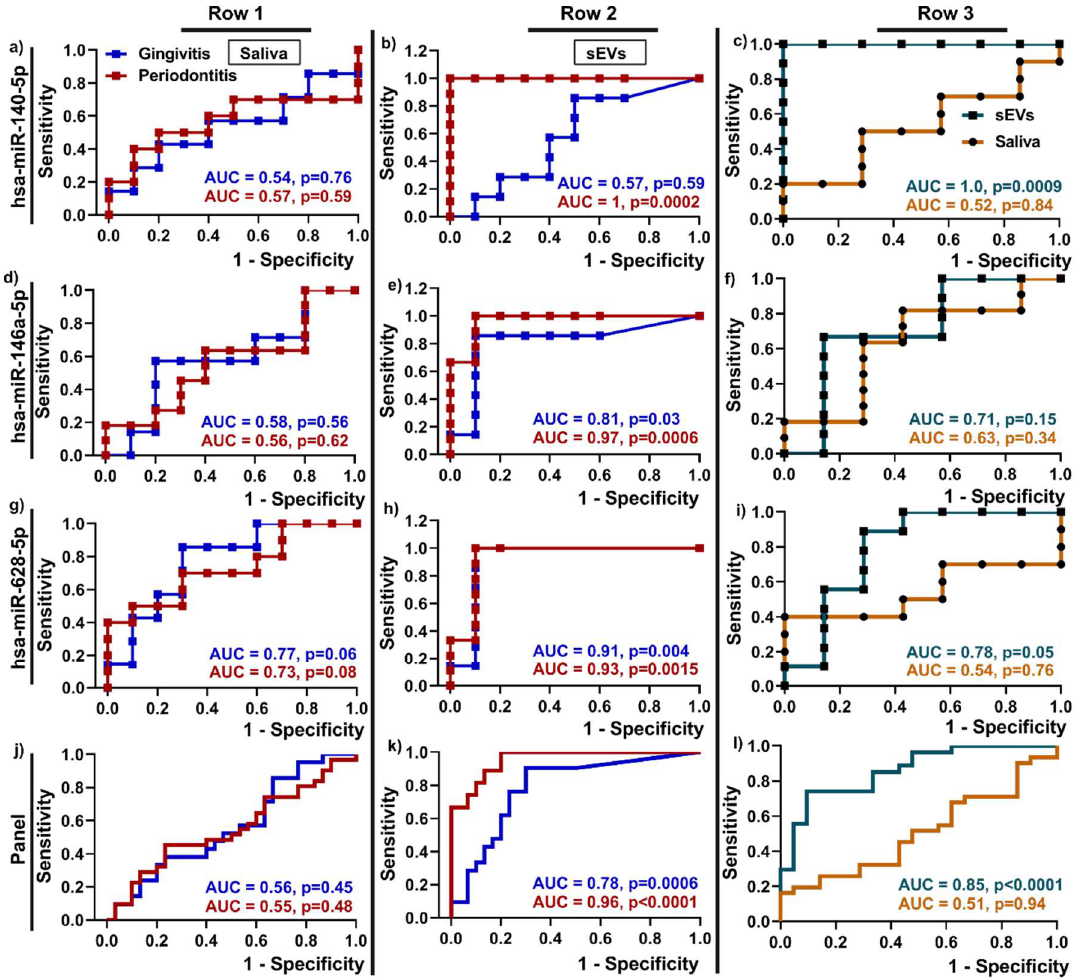
Figure 3. Discriminatory power of upregulated miRNAs hsa-miR-140-5p ( a – c ), hsa-miR-146a-5p ( d – f ), hsa-miR-628-5p ( g – i ) and the miRNA panel ( j – l ) in salivary sEVs from periodontally healthy, gingivitis and periodontitis patients by using Receiver Operating Characteristics (ROC) curves and area under the curve -AUC. Note: Row 1 and 2 show discriminatory power between periodontitis or gingivitis vs periodontal health of whole saliva miRNA ( a , d , g , j ) and sEV mRNA ( b , e , h , k ); Row 3 ( c , f , i , j ) shows the discriminatory power of upregulated miRNAs in saliva and sEVs between gingivitis and periodontitis patients.